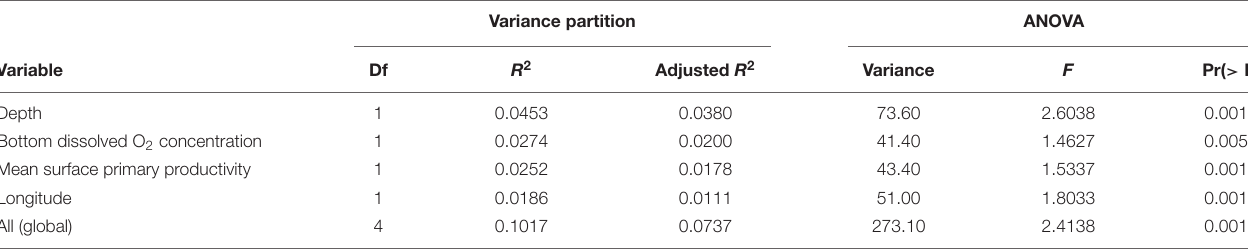
TABLE 2 | Environmental variables tested in the